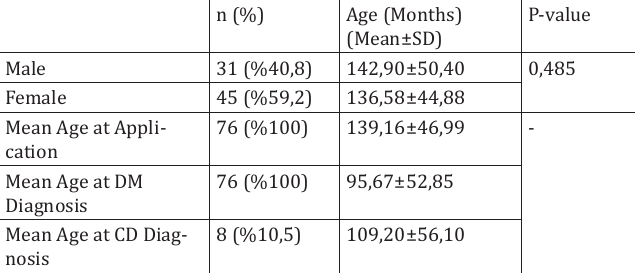
Comparison of the data according to the age at disease onset and gender.